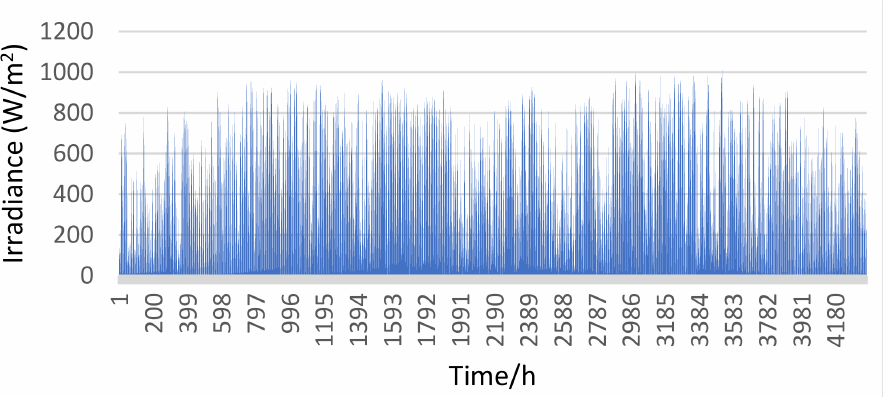
Figure 5. Time-segmented chart of the radiation amount received by the oblique uniaxial throughout the year (unit: W/m 2 ).